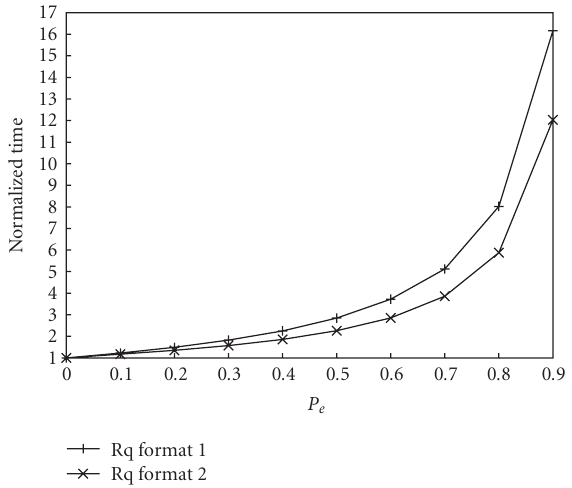
Figure 15: The average normalized amount of transmission time under heavy